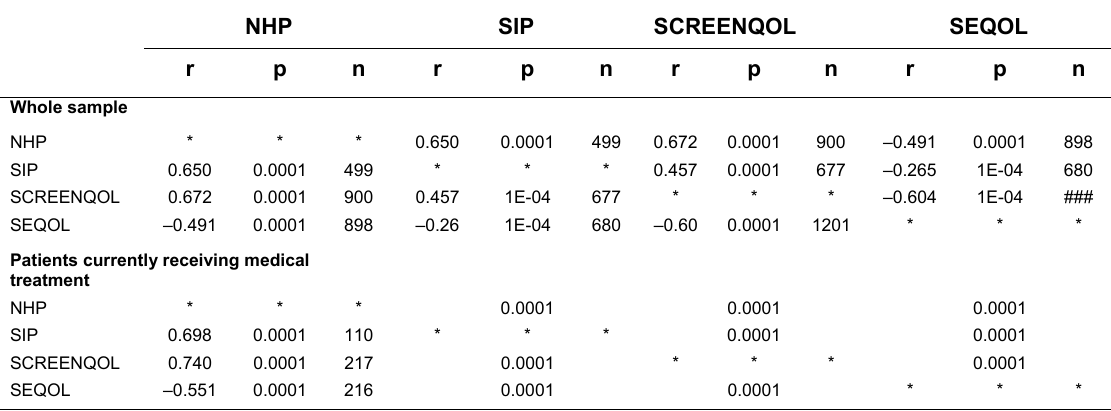
Table gives the Pearson correlation coefficient (r), the test value (p), and number of respondents (n) for each QoL